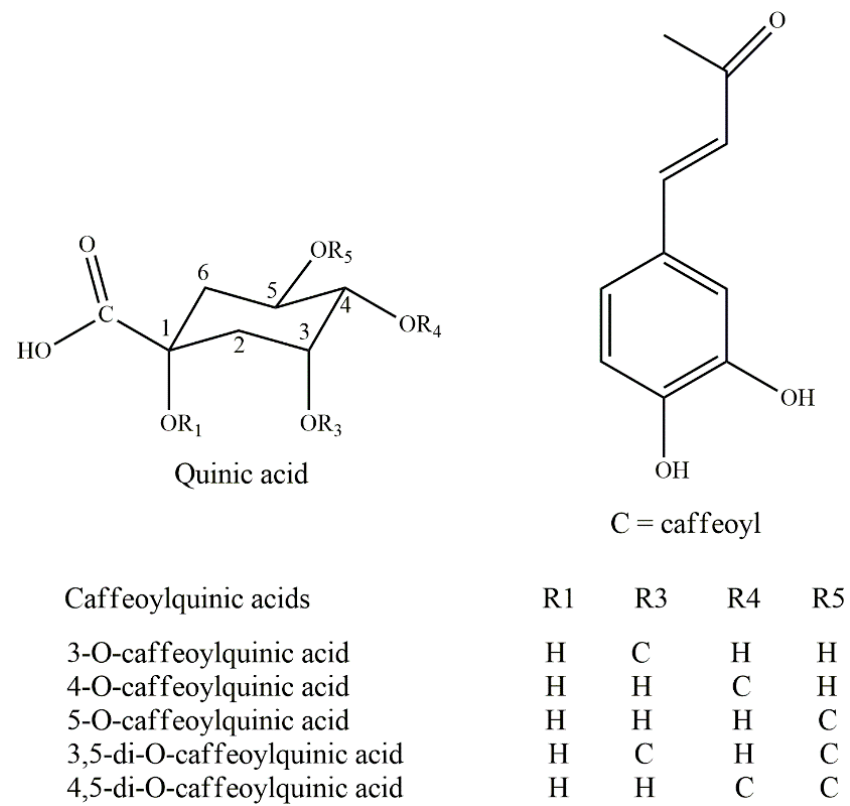
Figure 1. The chemical structures of caffeoylquinic acids.